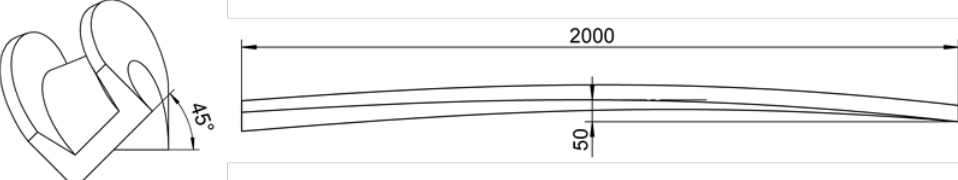
Figure 10. The hot straightening equipment model of the profile.